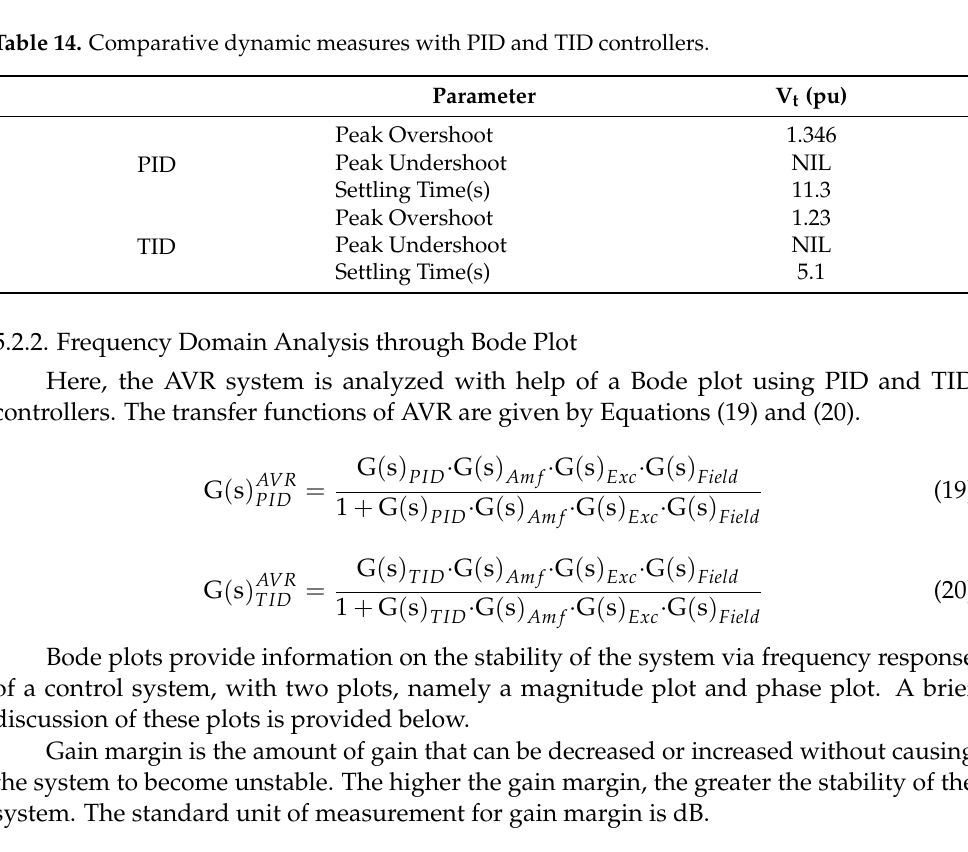
Table 13. Optimized TID controller parameters for AVR.